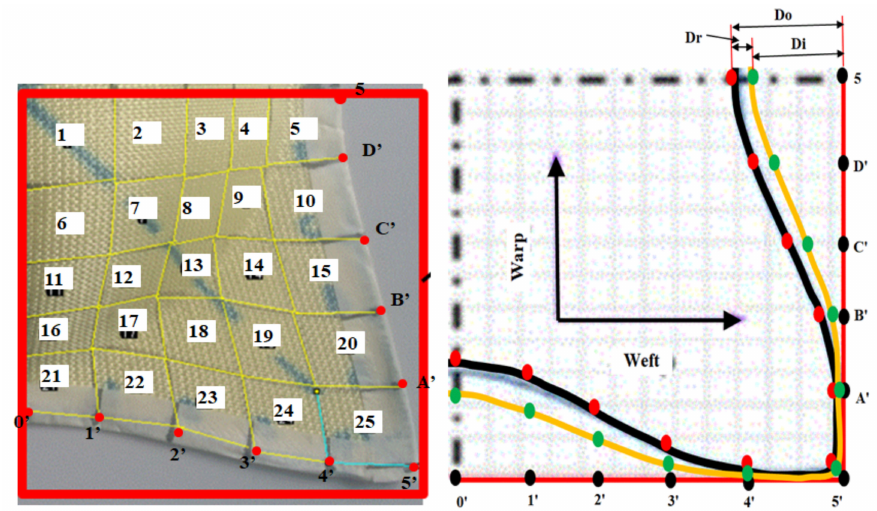
Figure 16. Pictorial and schematic representations of deformed preforms of the quadrant sub-region for drawing-in recovery representation.